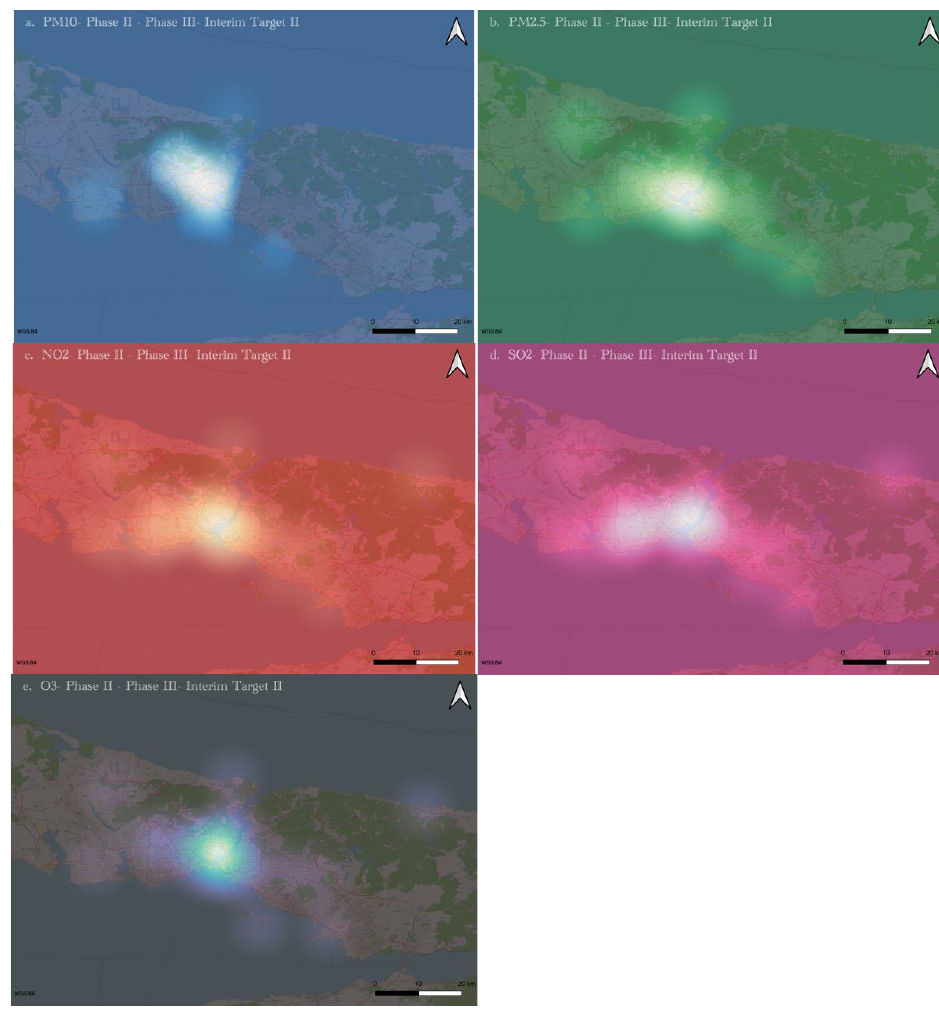
Figure 7. Spatial variations of Phase II and Phase III Differences in air quality exceedance: ( a ) PM 10 , ( b ) PM 2.5 , ( c ) NO 2 , ( d ) SO 2 , and ( e ) O 3.